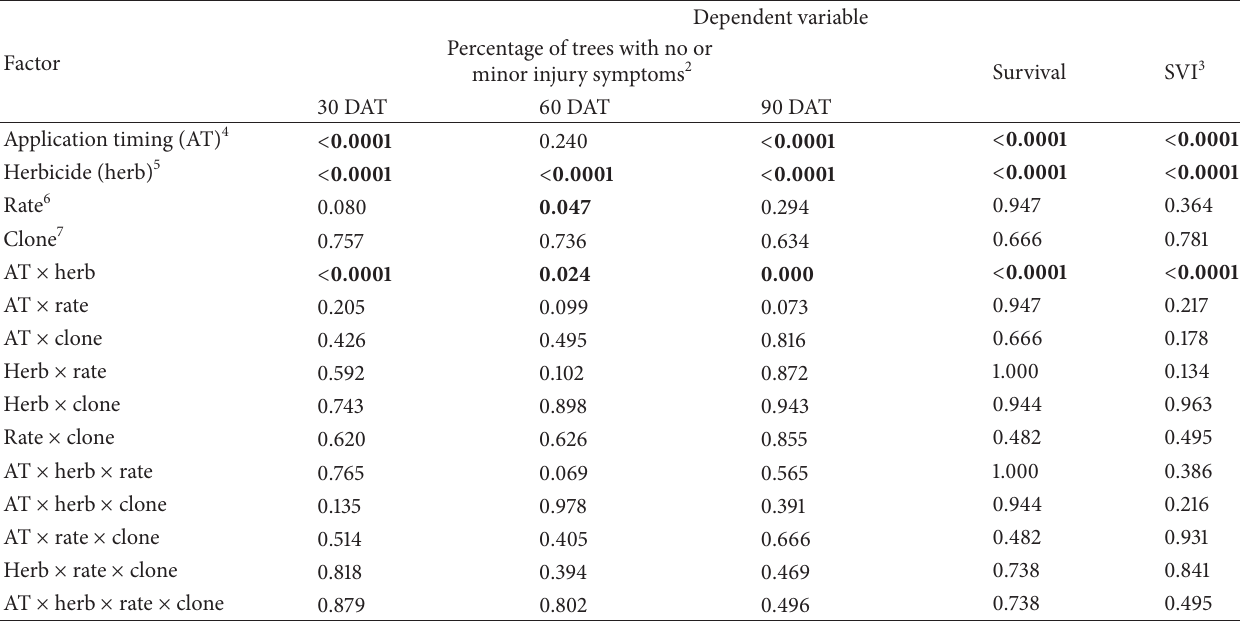
Table 4: ANOVA/ANCOVA 1 𝑃 values for the percentage of Eucalyptus urograndis trees showing no or minor injury symptoms at 30, 60, and 90 days after treatment (DAT), for survival and stem volume index (SVI) at the end of the first growing season, and for five herbicides applied at two rates and two application timings over newly planted rooted cuttings of two E. urograndis